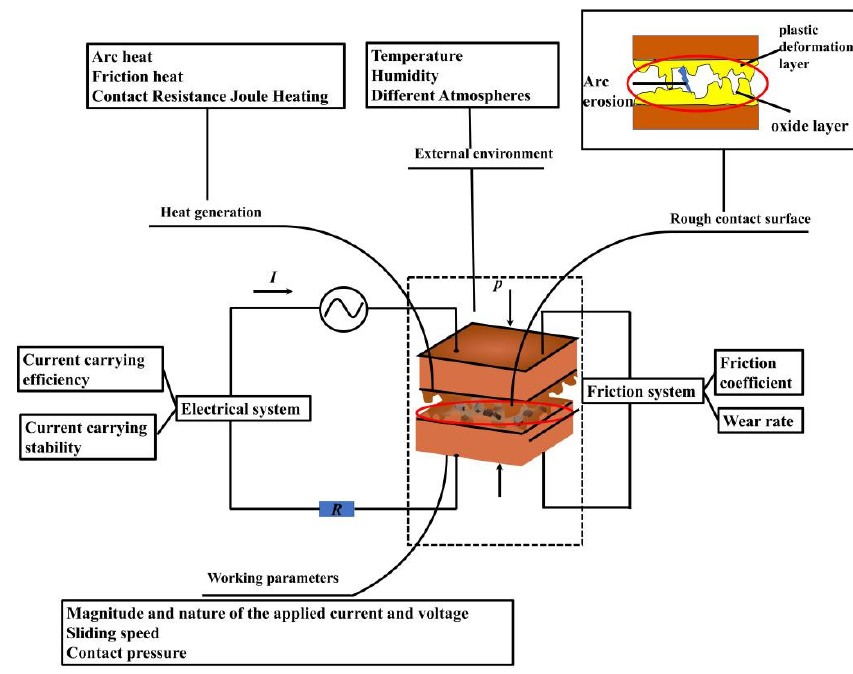
Figure 16. The current-carrying friction and wear contact system model.